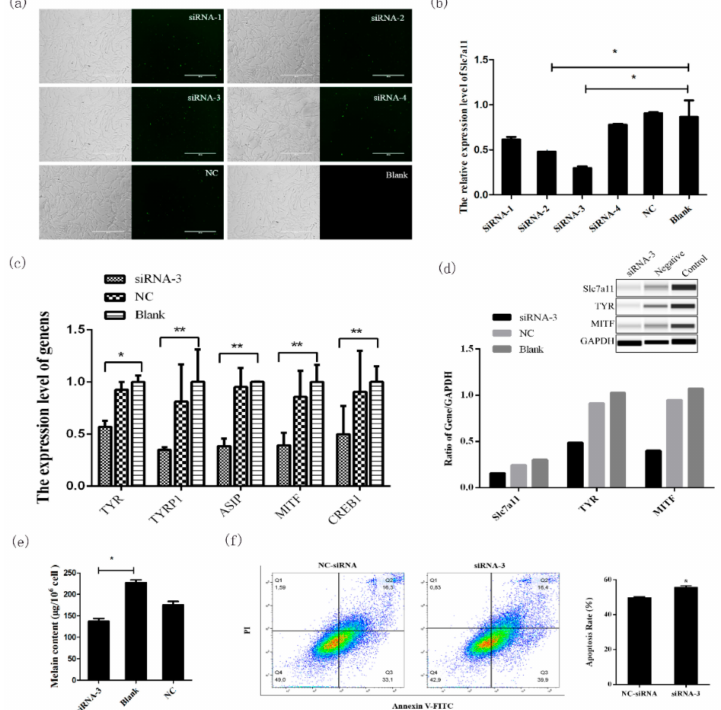
Figure 3. Melanogenesis-related gene expression and melanogenesis were inhibited by Slc7a11 knockdown. An extremly significant di ff erence was signified with “**” ( p < 0.01), and a significant di ff erence was signified with “*” ( p < 0.05). ( a ) Cell morphology 24 h after transfection of melanocytes by FAM-siRNA. Melanocytes in the logarithmic growth phase were transfected and the transfection was detected by the observation of green fluorescence. ( b ) Real-time PCR detection of Slc7a11 mRNA expression after siRNA interference. The best siRNA was screened for subsequent experiments. ( c ) E ff ects of Slc7a11 interference on the expression of pigmentation-related genes such as MITF , TYR , TYRP1 , CREB1 , and ASIP . ( d ) Detection of the expressions of MITF, TYR, and Slc7a11 (xCT) proteins in melanocytes by Wes. The relative expression levels of MITF, TYR, and Slc7a11 (xCT) proteins were calculated and analyzed by the Compass program. ( e ) The e ff ect of Slc7a11 knockdown on melanogenesis in melanocytes. Melanocytes were collected after siRNA-3 transfection and the melanin level was measured using a microplate reader. ( f ) Melanocyte apoptosis rate was determined after knockdown of Slc7a11